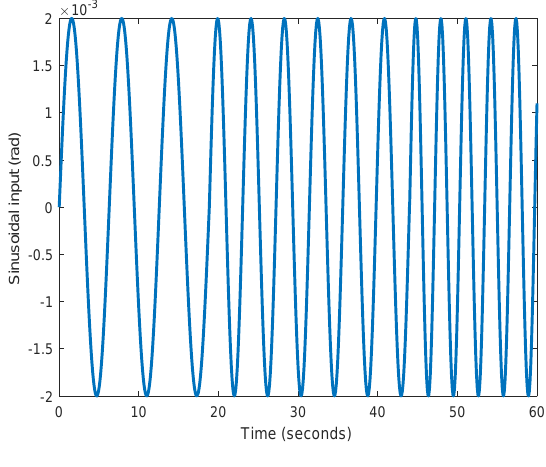
Figure 3. Input signal to CarSim.